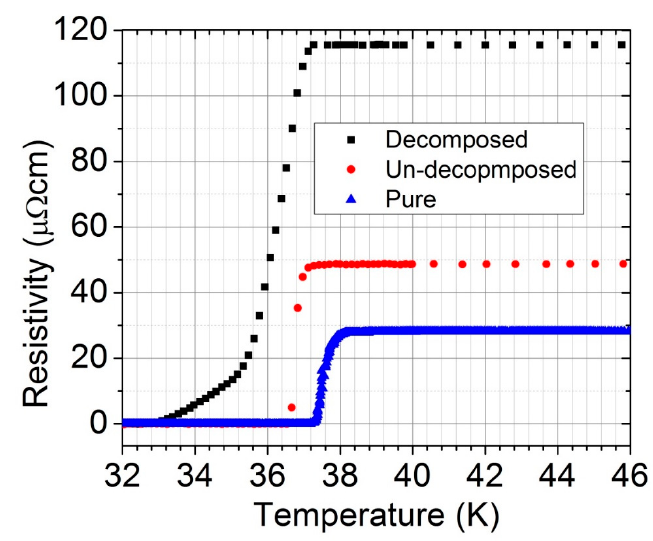
Figure 6. The resistivity of pure and CNTs-doped MgB 2 as a function of the temperature near the transition temperature. Table 1. The lattice parameters, estimated C (%), and effective grain connectivity of the samples.